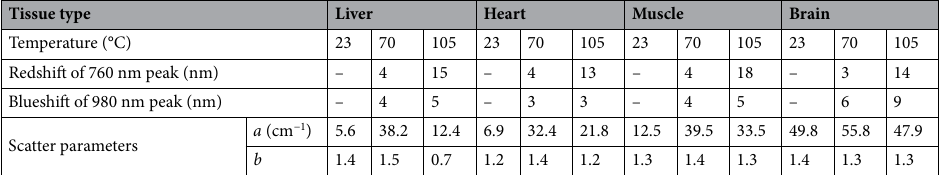
Table 1. Quantification of the selected features observed in the different tissue types with RF-based thermal treatment at the two temperatures. The scattering parameters a and b are related to the density and size of the scattering components in the medium. From the absorption spectra, the relative redshift in the Hb peak and blue shift of the water peak at 980 nm are quantified using a cubic spline interpolation of the measured data.